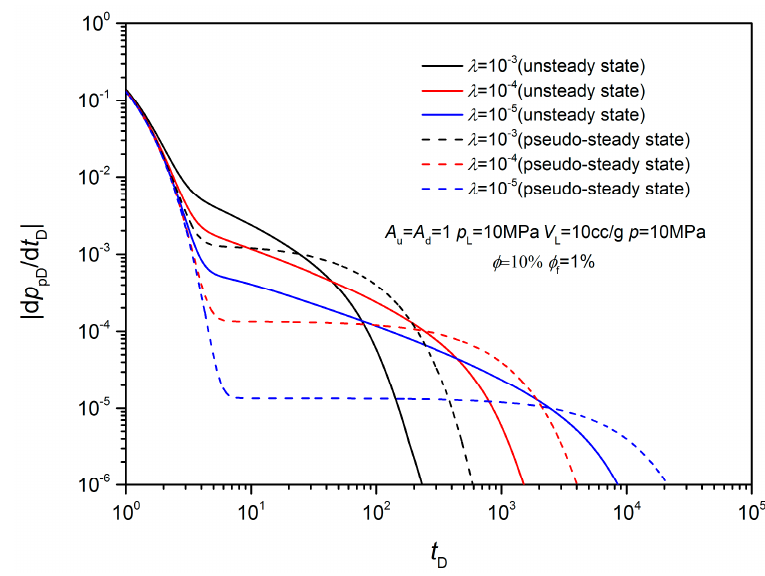
Figure 17. The pseudo-pressure derivative at the early stage.